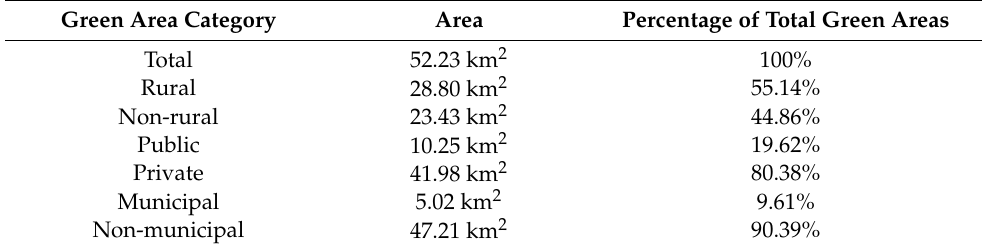
Table 9. Classification of green areas in